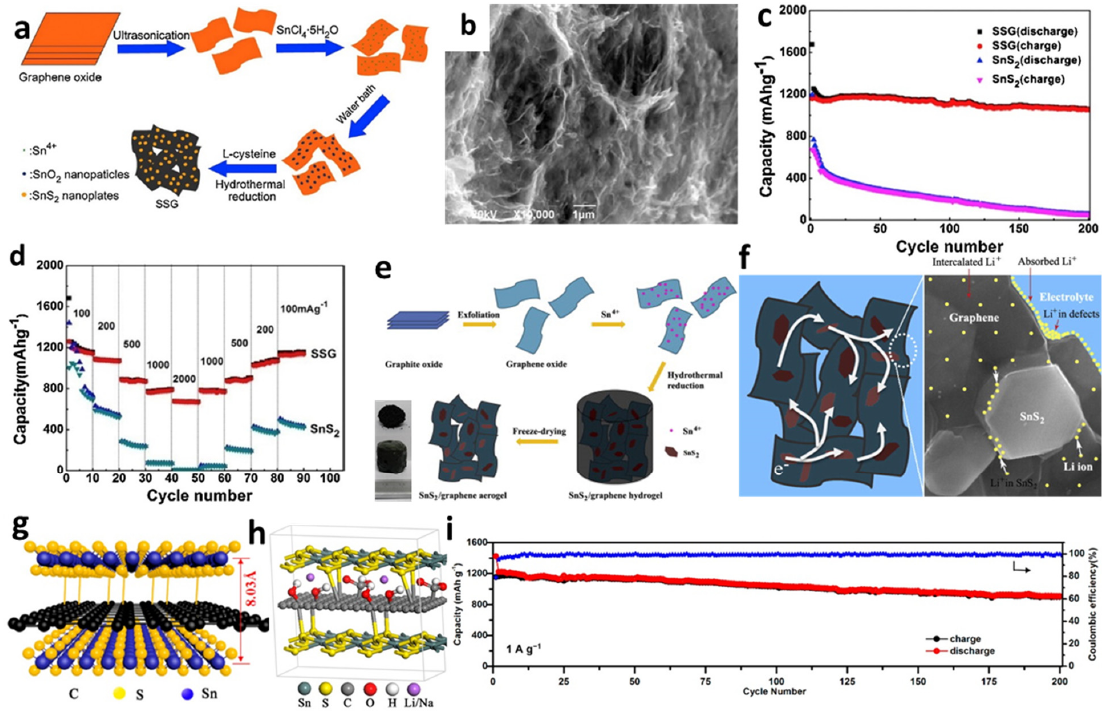
Figure 9. ( a ) Schematic formation process, ( b ) an SEM image, ( c ) cycling performance, and ( d ) rate capability of SSG. Reprinted with permission from Ref. [148]. Copyright 2015 Elsevier. ( e ) Fabrica- tion process, and ( f ) schematic representation of electron transmission and lithium ions storage of SnS 2 /GAs. Reprinted with permission from Ref. [150]. Copyright 2013 Elsevier. ( g ) Schematic illus ‐ tration, ( h ) molecular model, and ( i ) high rate cycling performance of SnS 2 /RGO/SnS 2 . Reprinted with permission from Ref. [149]. Copyright 2019 ACS.